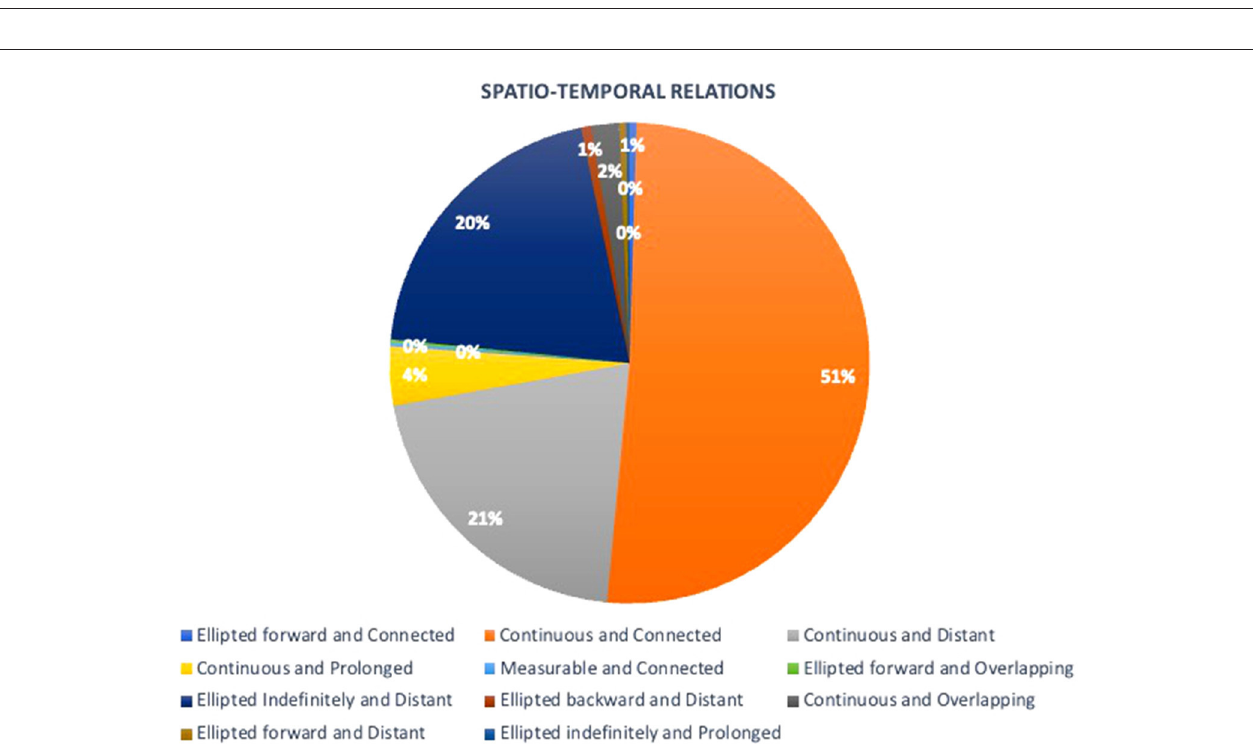
FIGURE 10 | Spatio-temporal relations on the level of Plane in the Heineken